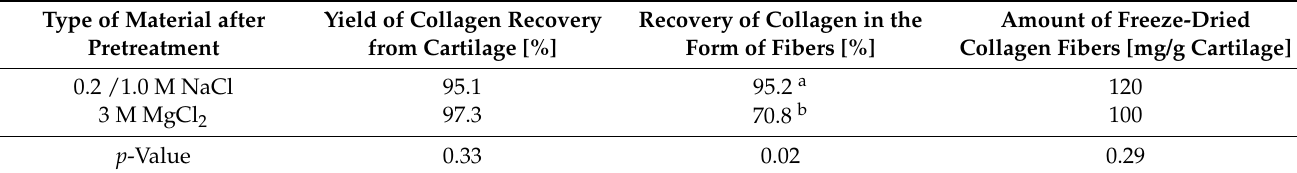
Table 3. Characteristics of the reconstituted and freeze-dried collagen fibers.